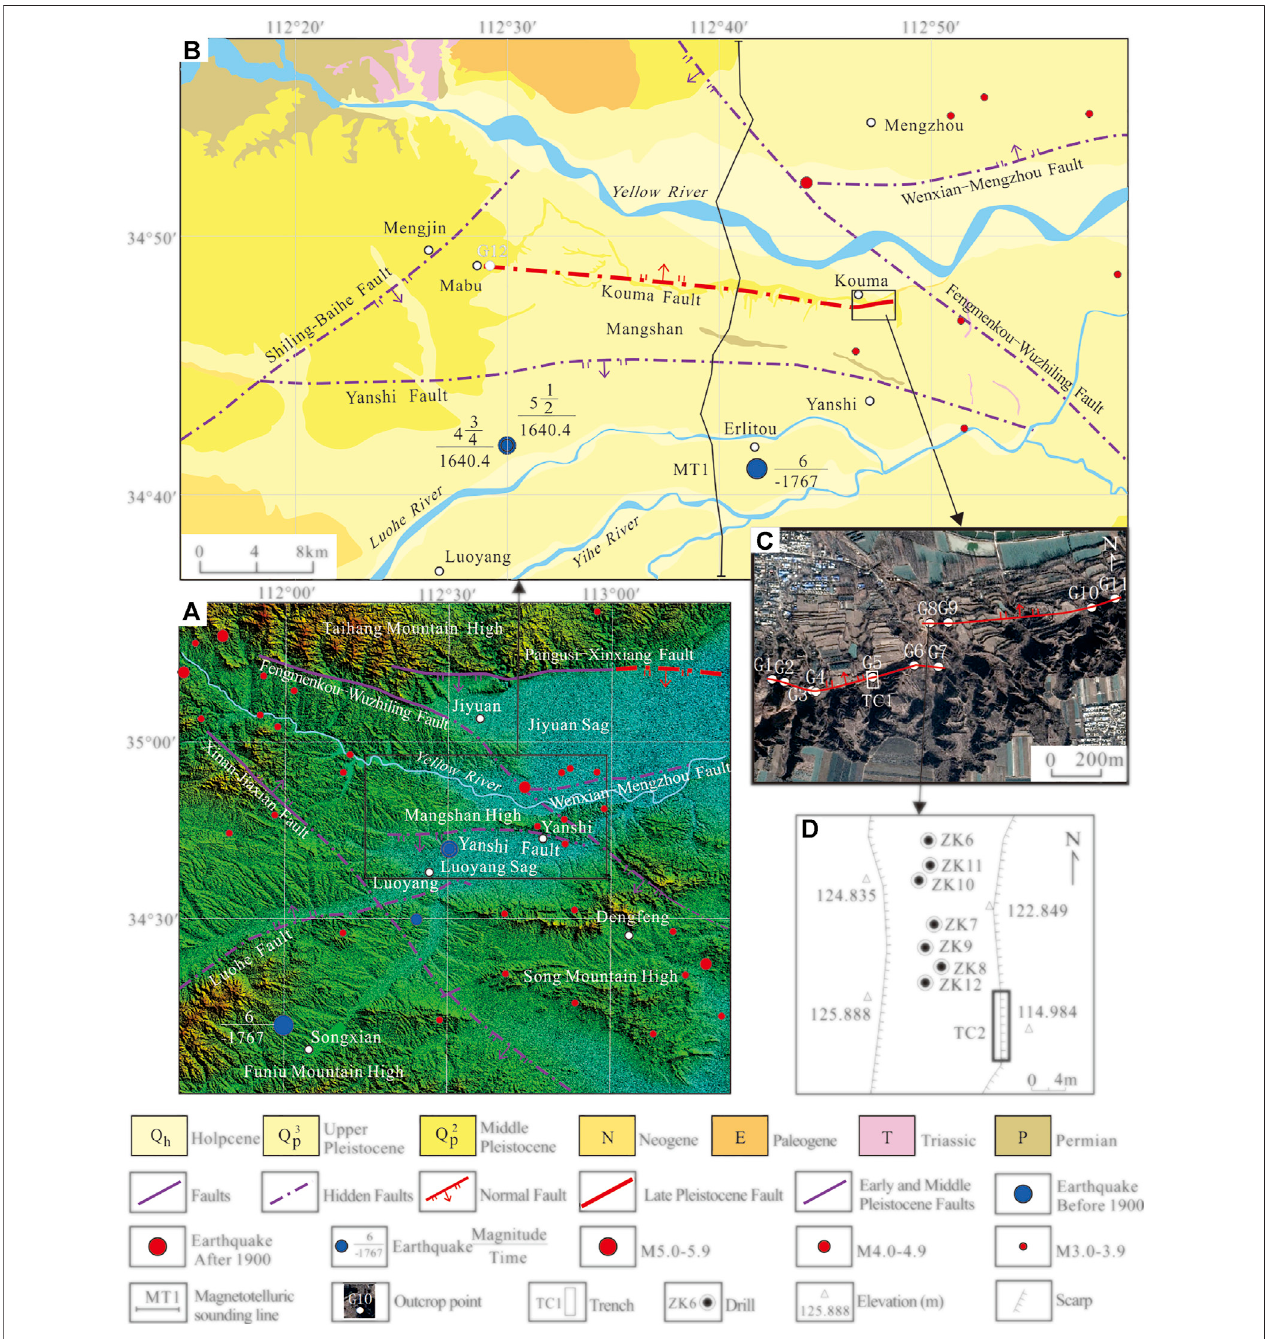
FIGURE 1 | The seismic and geological map of the study area. (A) Distribution map of main faults and earthquakes in study area. (B) The seismic and geological map of Kouma rigion. (C) The location map of fault outcrop points and trench. (D) The location map of trench and drills.